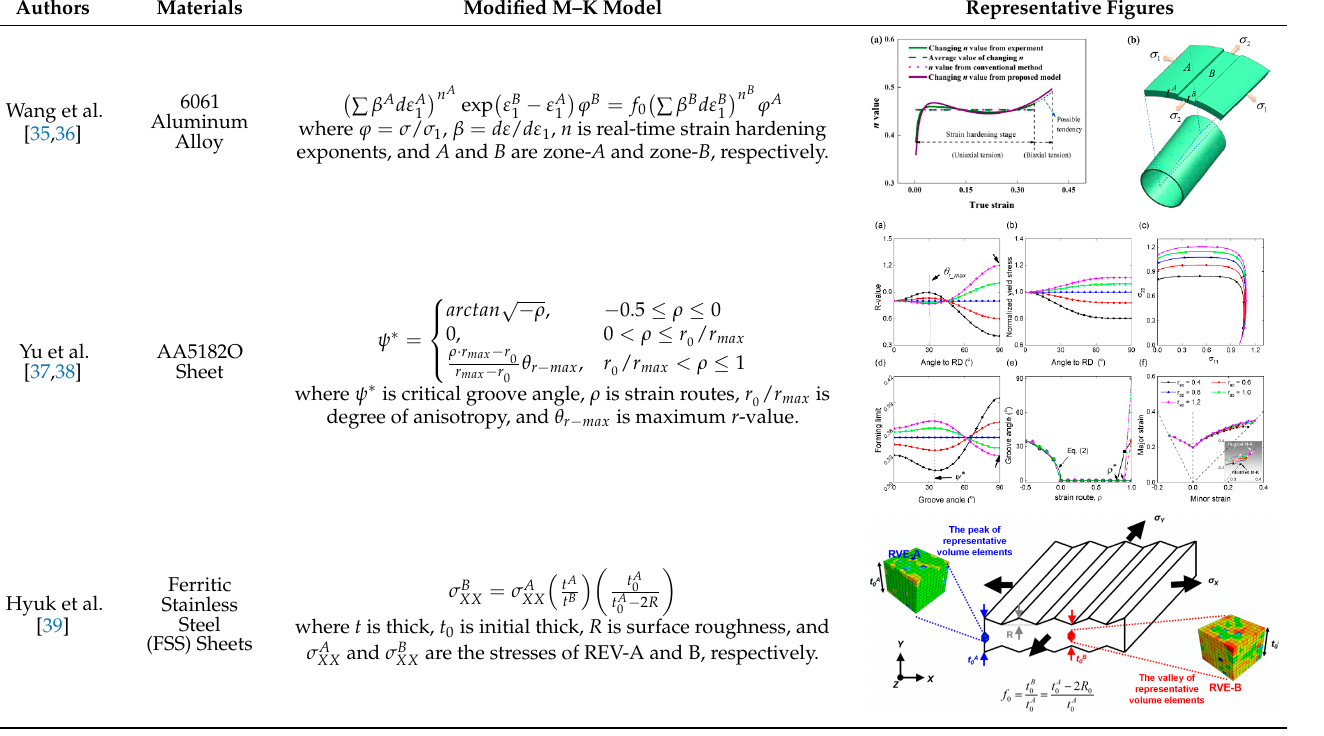
are zone- A and zone- B ,